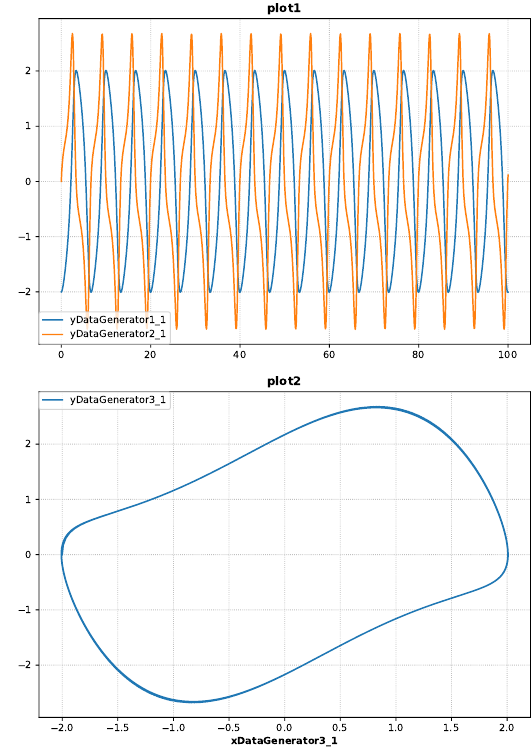
Figure A.13: The simulation result gained from the simulation description given in Listing A.8. Simulation with SED-ML web tools [2].